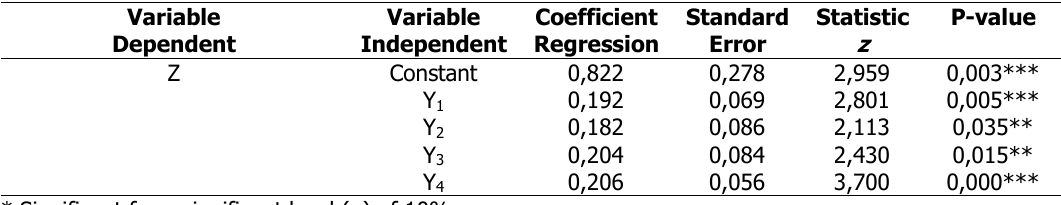
Table 8. T test results for the significance of the coefficient of equations y1, y2, y3 and y4 Variable Variable Coefficient Standard Statistic P-value Dependent Independent Regression Error z Z Constant Y 1